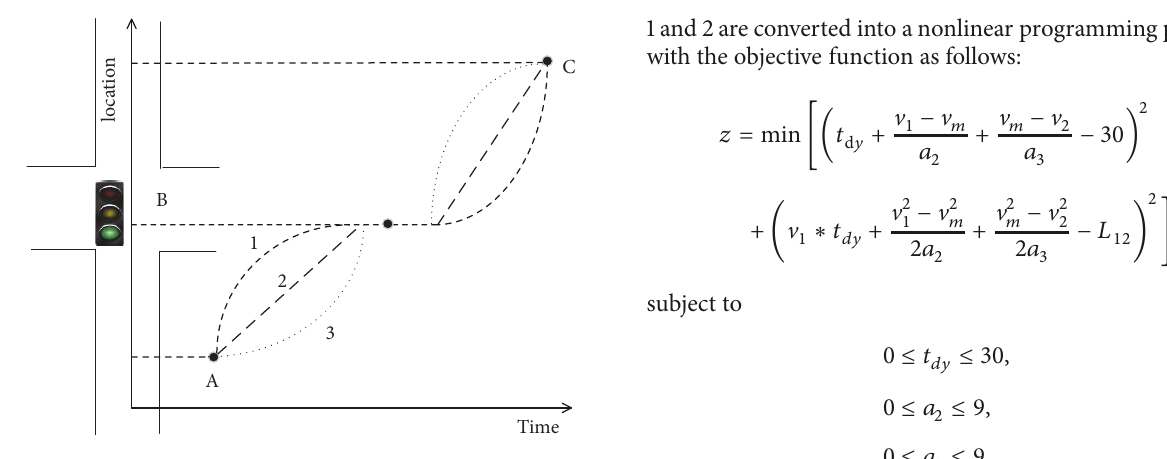
Figure 2: Schematic of trajectory reconstruction with low- frequency probe